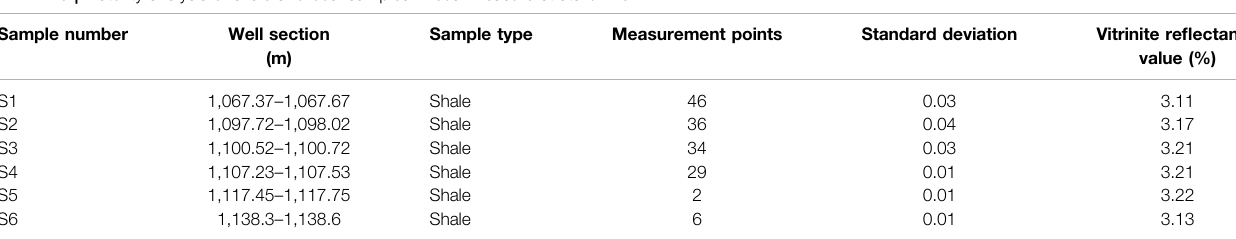
TABLE 3 | Maturity analysis of shale and coal samples in coal measure strata of well Y4. Sample type Measurement points Standard